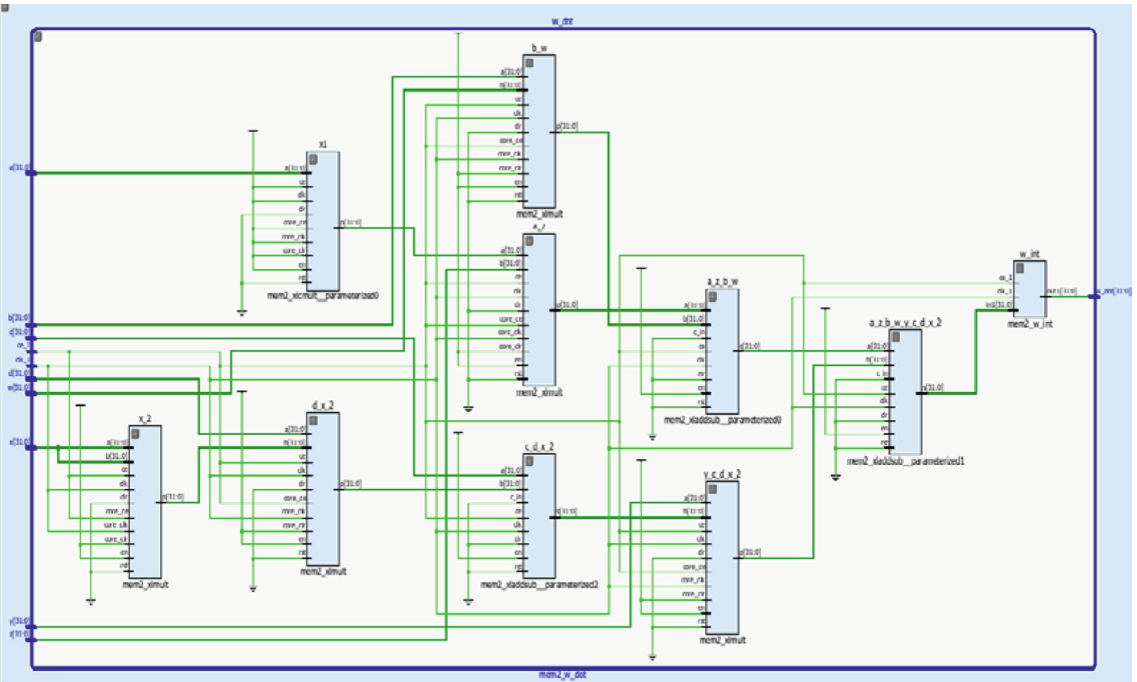
Figure 21: The RTL schematic of memristive hyperjerk chaotic system implemented in Kintex-7 using hardware-software cosimulation.